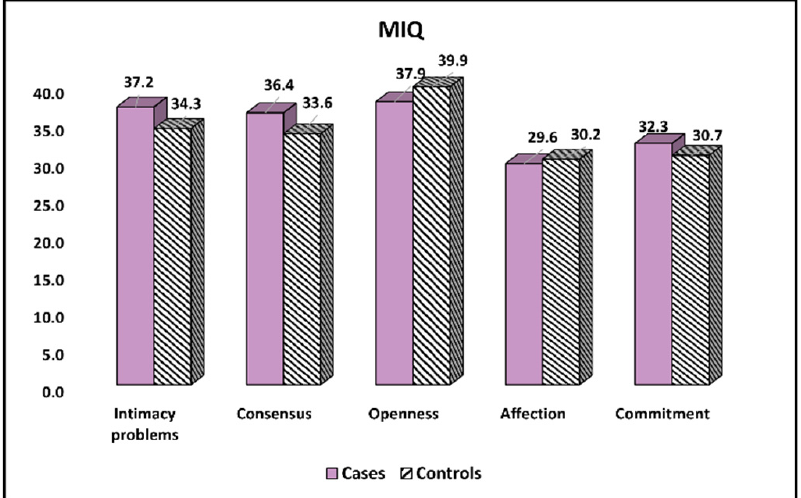
Figure 4. Comparison of MIQ survey results between cases and controls.